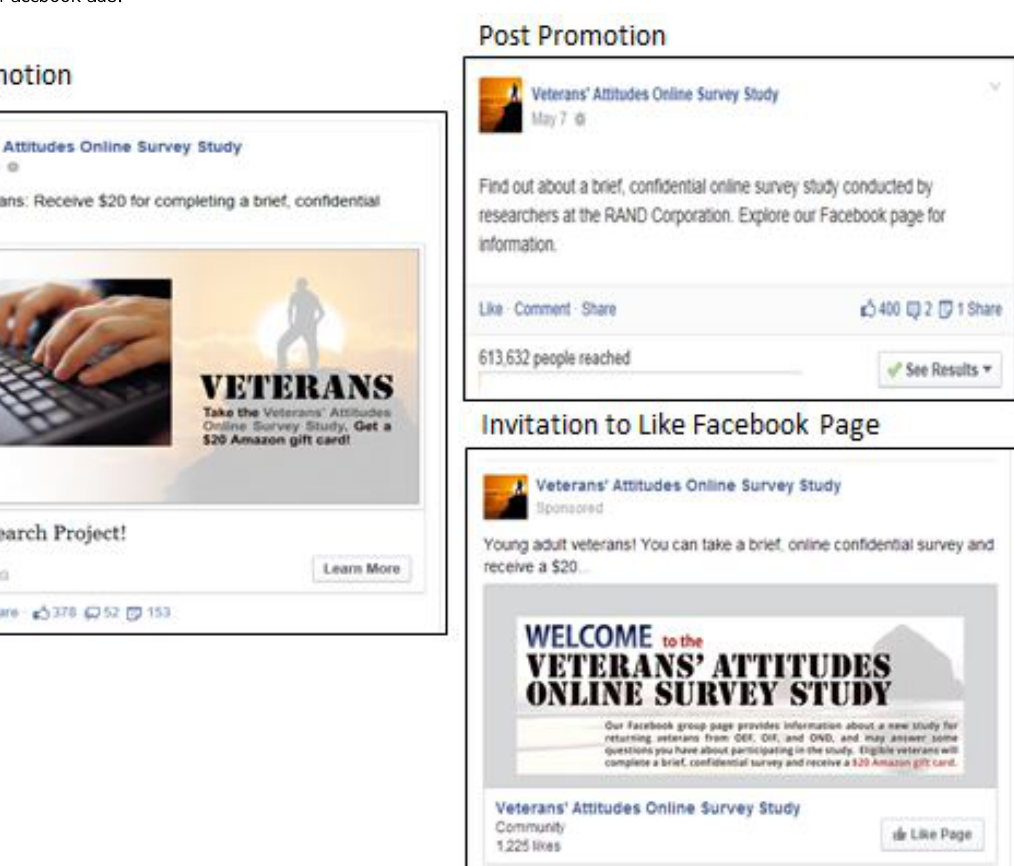
Figure 1. Examples of Facebook